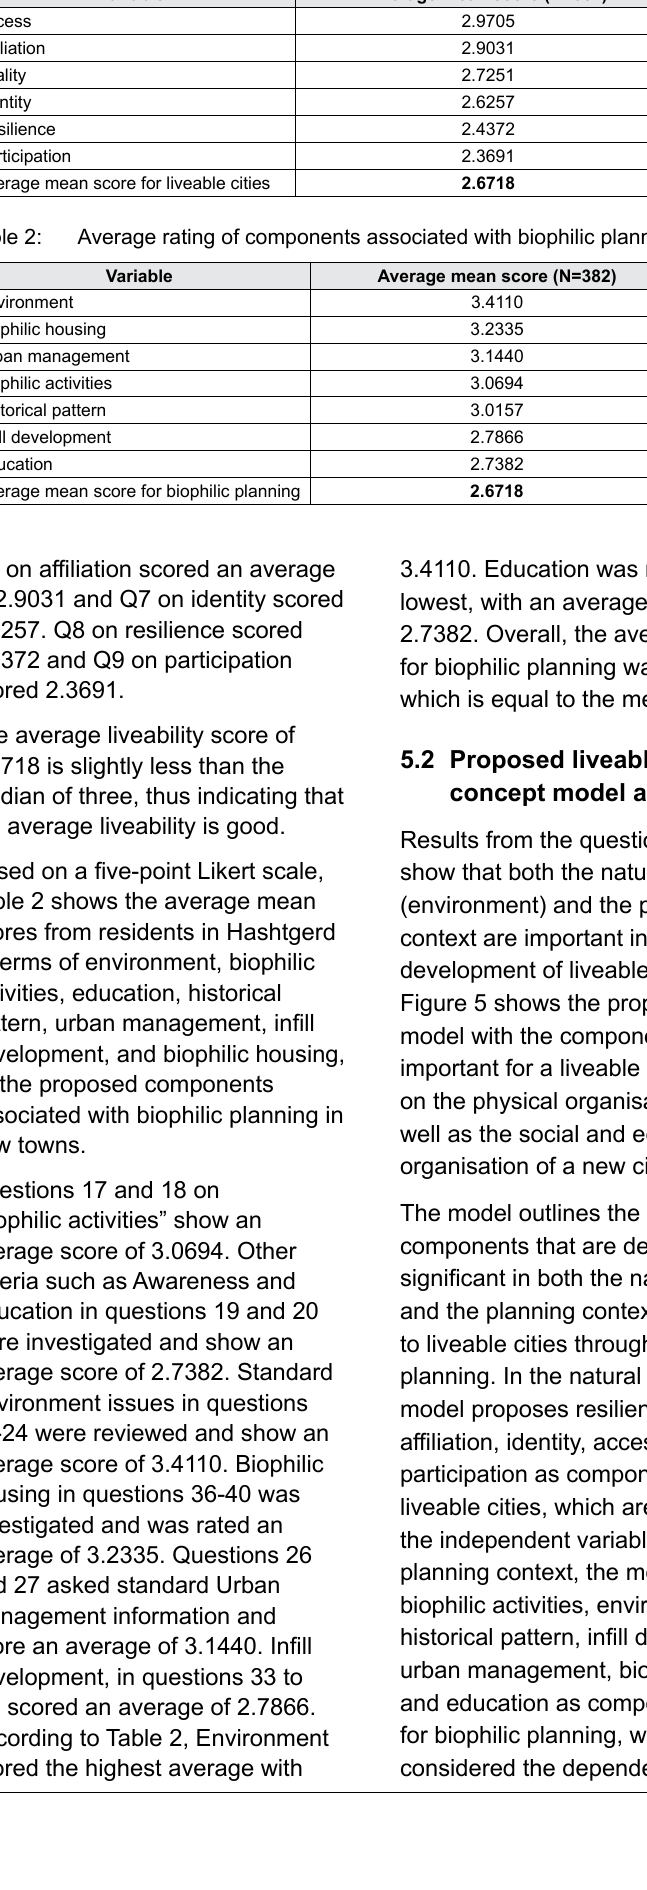
Mean value of the components associated with liveable cities